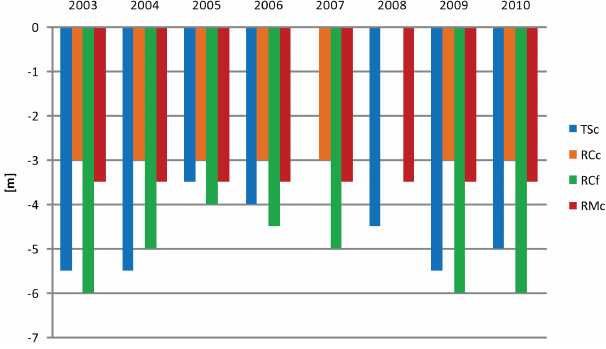
Fig. 6. Active layer depth of the last eight years for the boreholes with